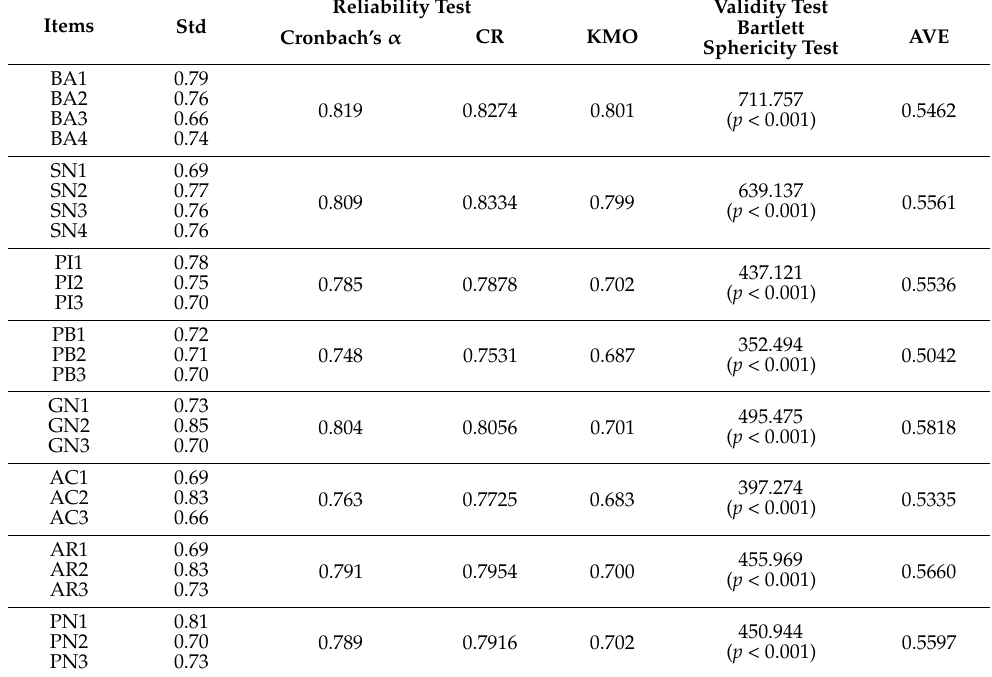
Table 3. Analysis results of variable reliability, validity, and factors.